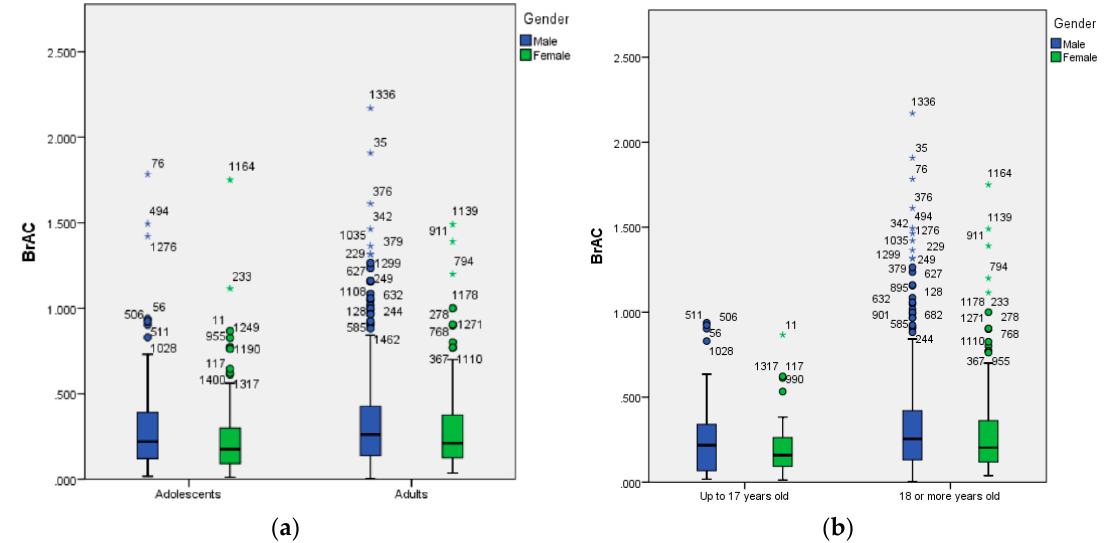
Figure 1. ( a ) Boxplot of BrAC by chronological age (adolescents and young adults) and gender (male and female); ( b ) boxplot of BrAC by age limit for alcohol drinking in Spain (up to 17 years old and 18 or more years old) and gender (male and female).